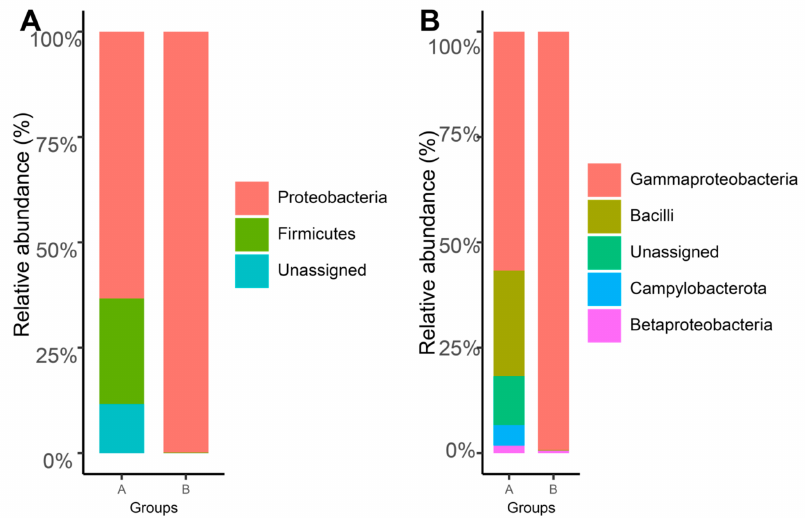
Figure 2. The taxonomic composition of bathymodiolin mussel G. haimaensis (Group A) and vesicomyid